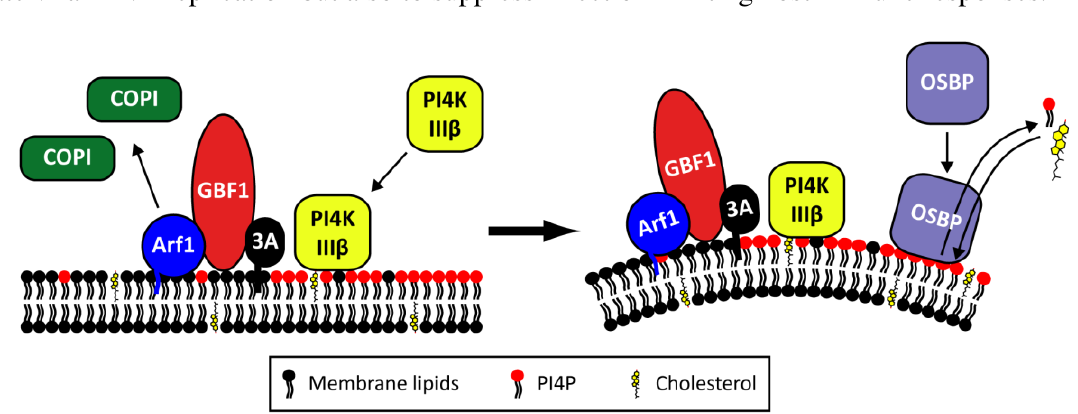
Figure 5. The proposed role of Golgi-localized host factors in Enterovirus replication. Upon infection, the viral 3A protein recruits GBF1 and indirectly Arf1 to the replication organelles. As a result, COP-I is lost from the membranes. At the same time, PI4KIIIβ is recruited by 3A through a GBF1/Arf-independent mechanism, resulting in an increase in PI4P lipids. OSBP then binds to the PI4P lipids and mediates a PI4P/cholesterol counterflow between the membranes of the replication organelles and the ER.